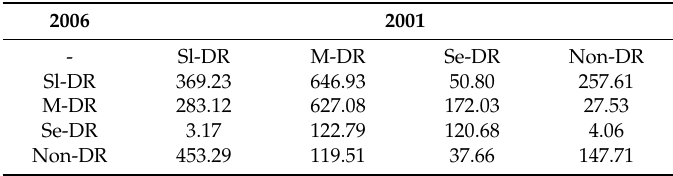
Table 6. Rangeland degradation changes (km 2 ) from 2001 to 2006 in Linxia